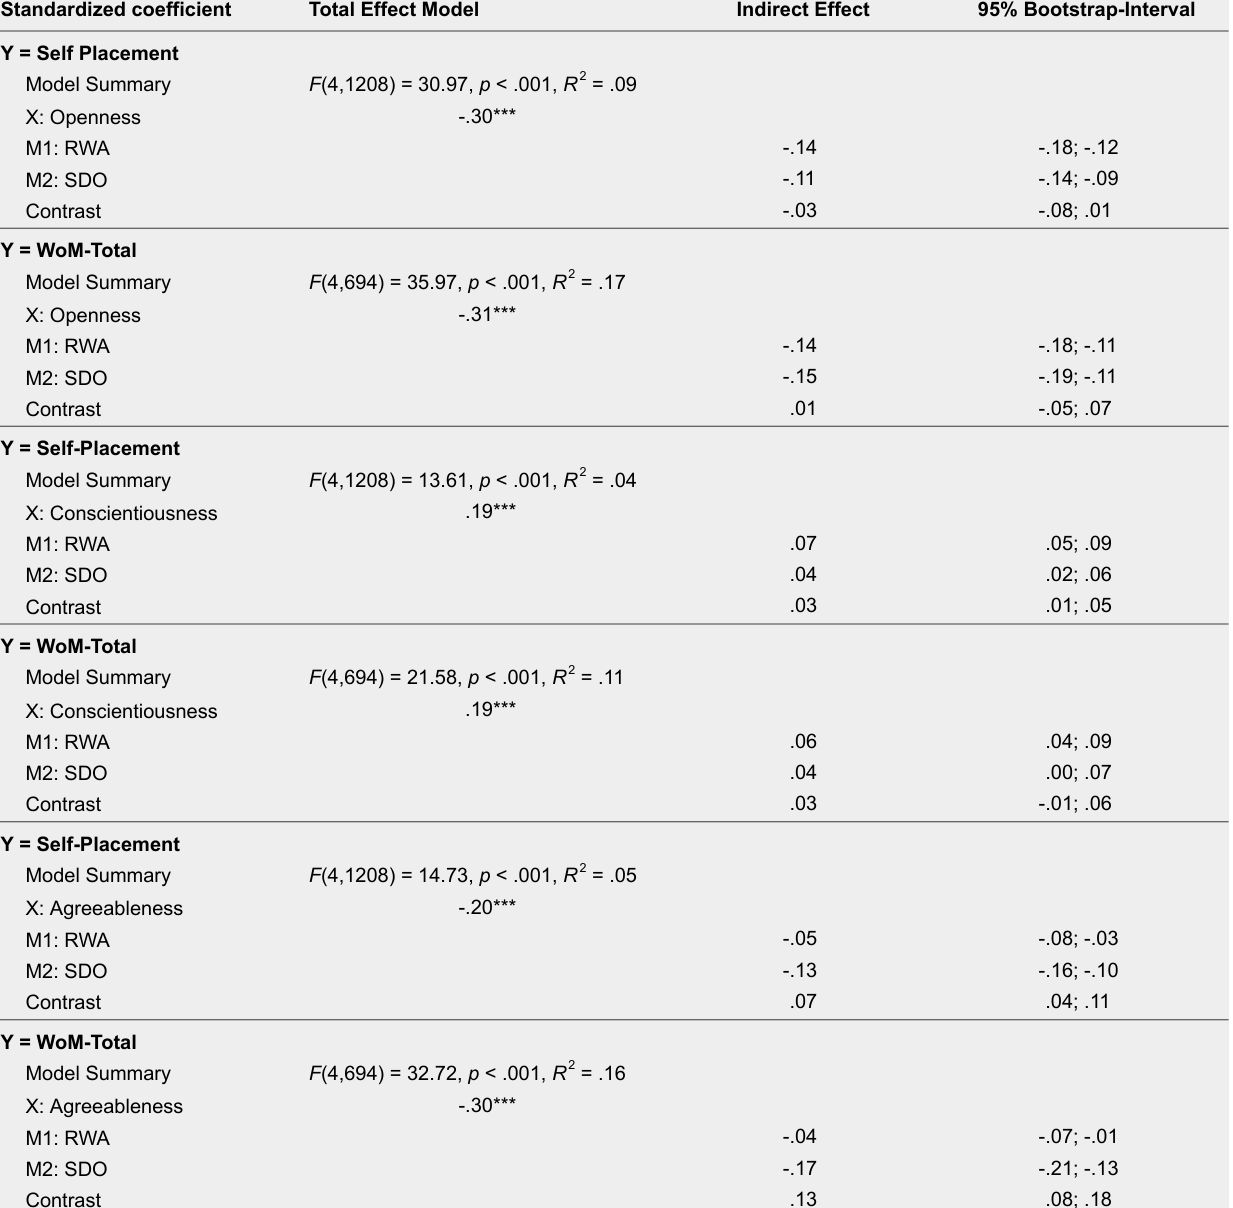
Parallel Mediation